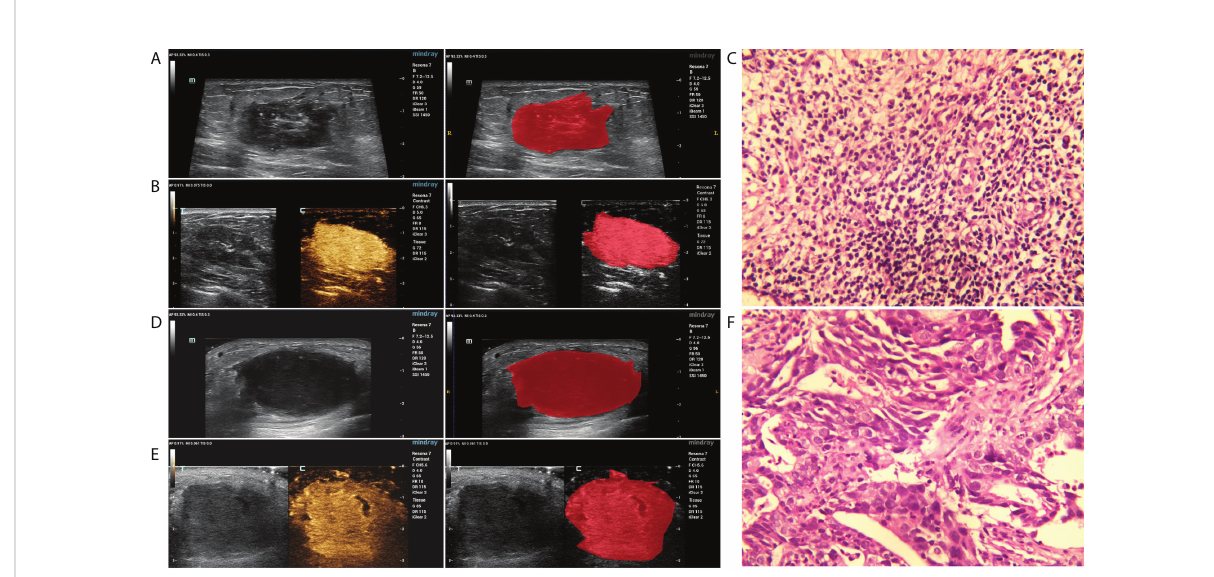
FIGURE 2 The representative results of the breast lesion segmentation. (A, B) The original GSUS, CEUS images and the segmentation of a 32-year-female patient con fi rmed with PDM/DE. (C) The sample (hematoxylin and eosin) with PDM/DE (400x). (D, E) The original GSUS, CEUS images and the segmentation of a 49-year-old female patient con fi rmed with IDC. (F) The sample (hematoxylin and eosin) with IDC